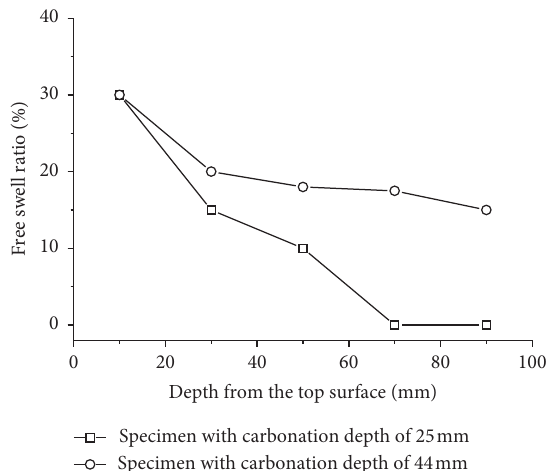
Figure 12: Distribution of free swell ratio of lime-stabilized ex- pansive soil after carbonation.